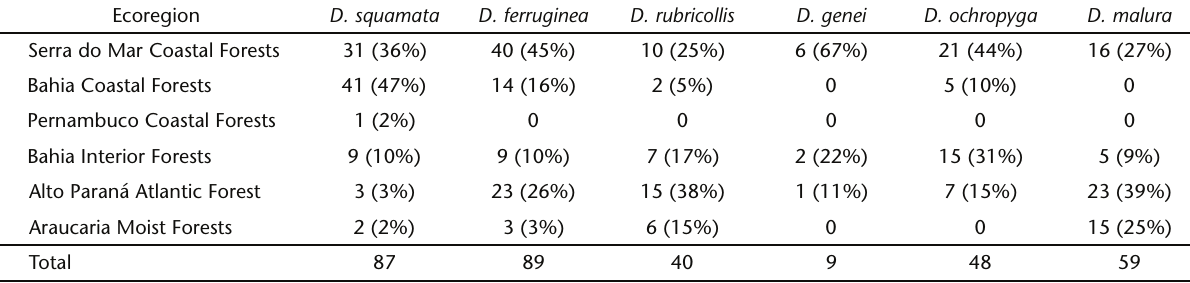
Table II. Results of one way analysis of variance on climate data and the Scheffé multiple range test. For each variable are presented the F value, the associated probability (p) and the species which average values were significantly different. (Meantemp) mean annual temperature, (Mintemp) mean annual minimum temperature, (Maxtemp) mean annual maximum temperature; (Abmin) absolute minimum temperature, (Abmax) absolute maximum temperature, (Prec) annual total precipitation, (Neb) mean annual nebulosity,